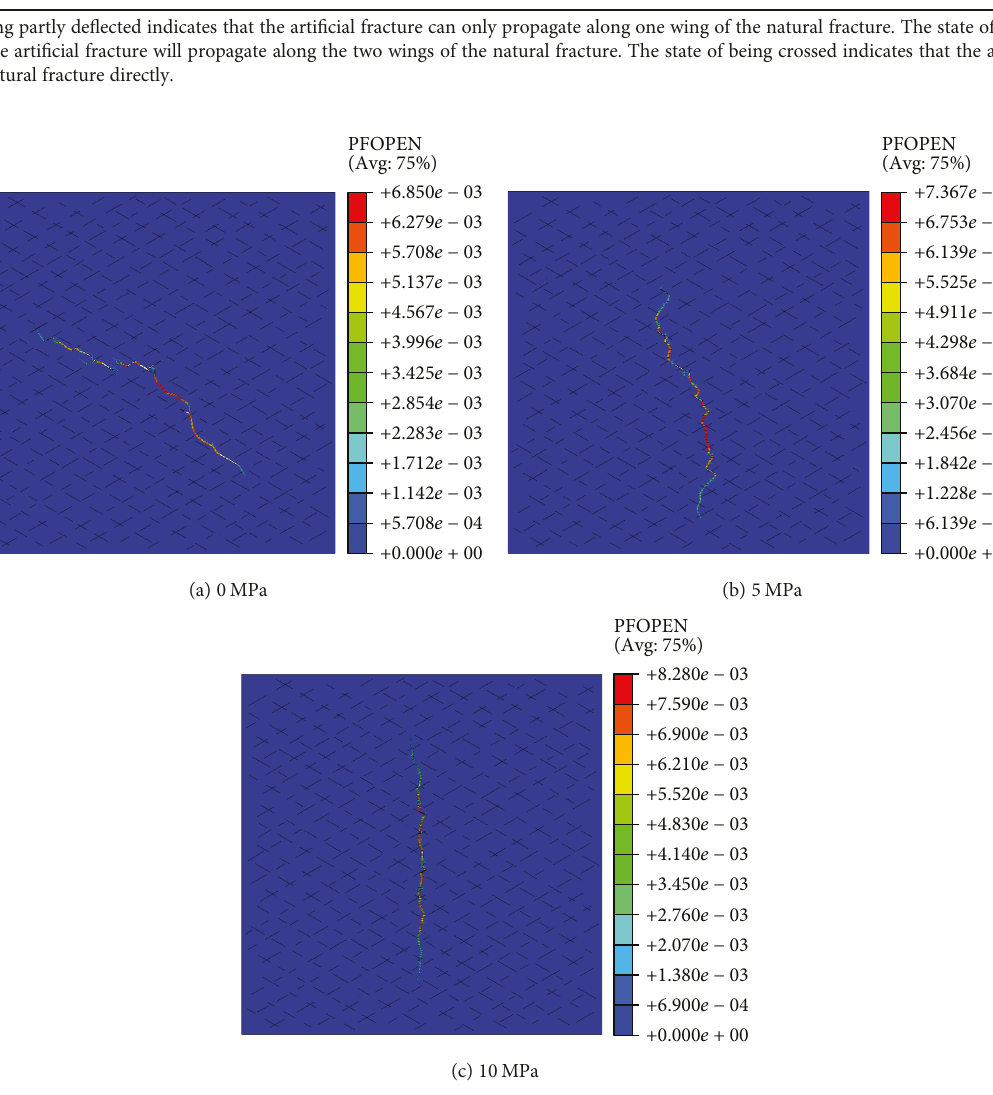
Figure 11: The e ff ects of in situ horizontal stress di ff erence on fracture